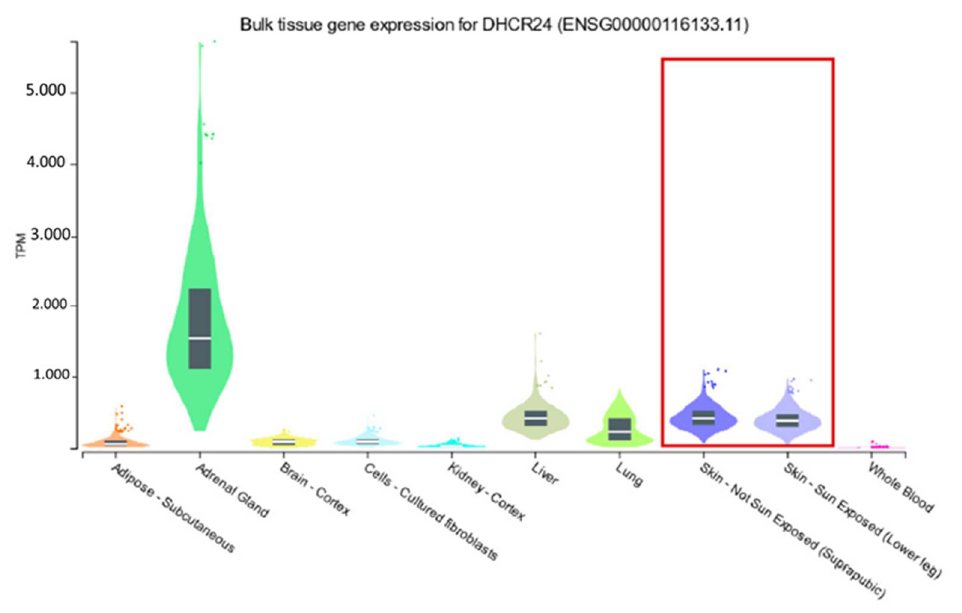
Figure 4. Bulk expression analyses of DHCR24 in different tissues with an accentuated expression in skin. Data from the GTex online database.